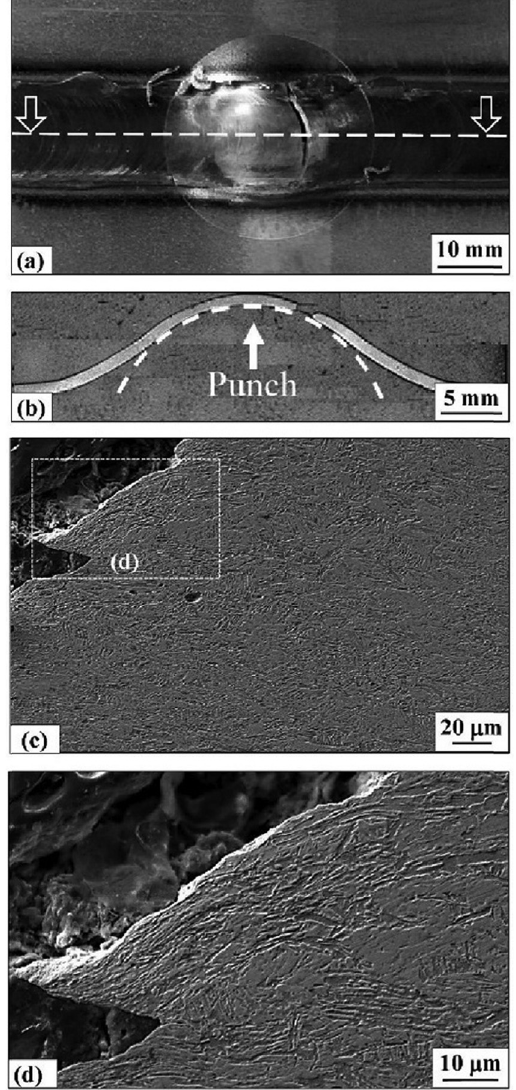
Figure 6: ( a ) Top macro - view, ( b ) cross - sectional macro - view, and ( c ) and ( d ) fracture zone microstructure of the FSPed cupping test